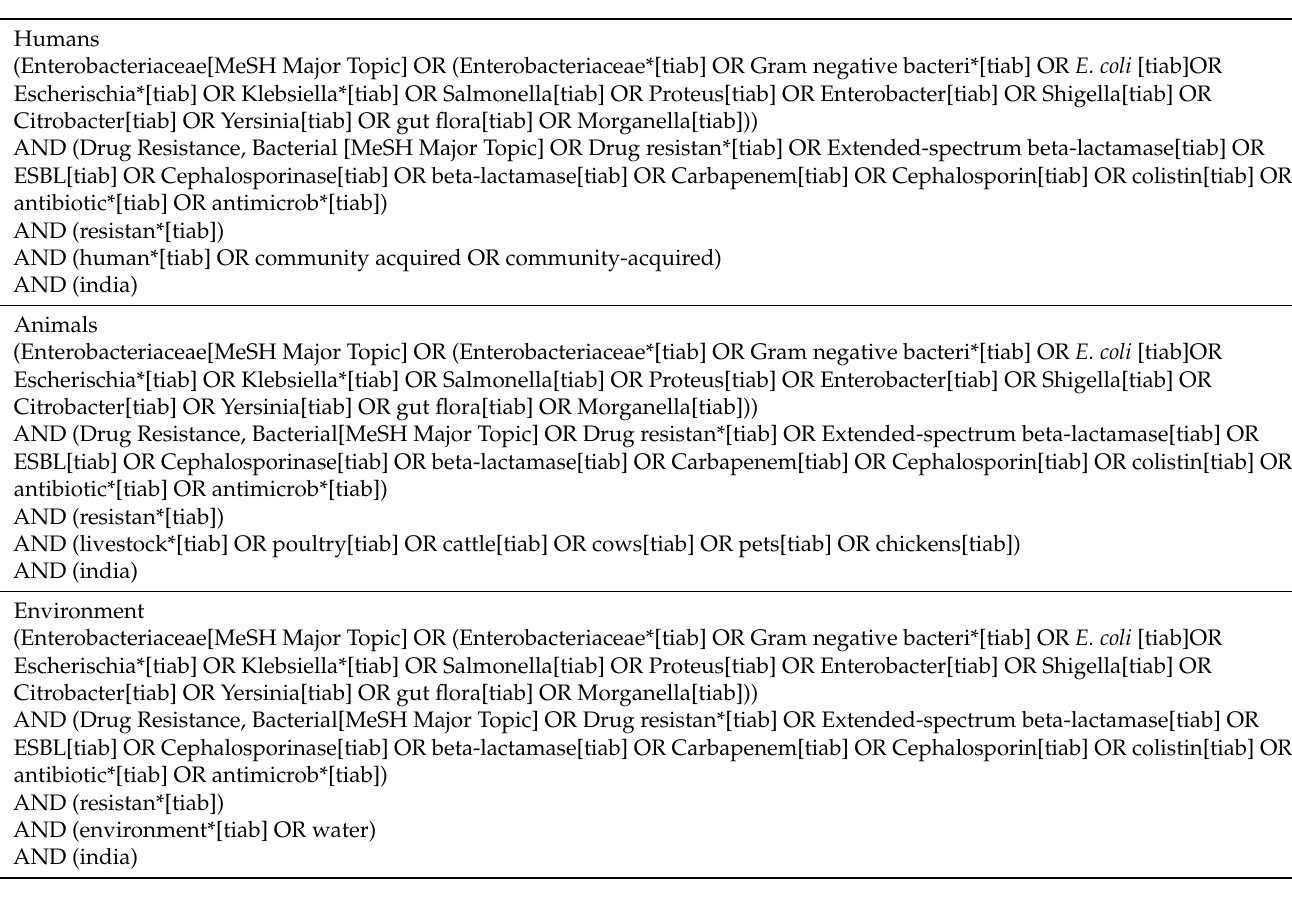
Table A1. Search